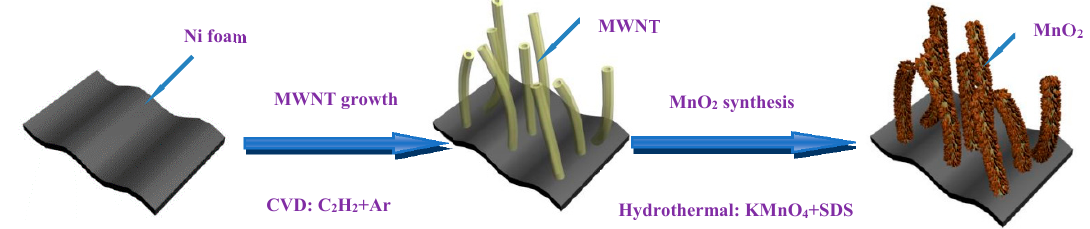
Figure 1. Production process of MnO 2 –MWNT–Ni foam composite. MWNT: multiwalled carbon nanotube.